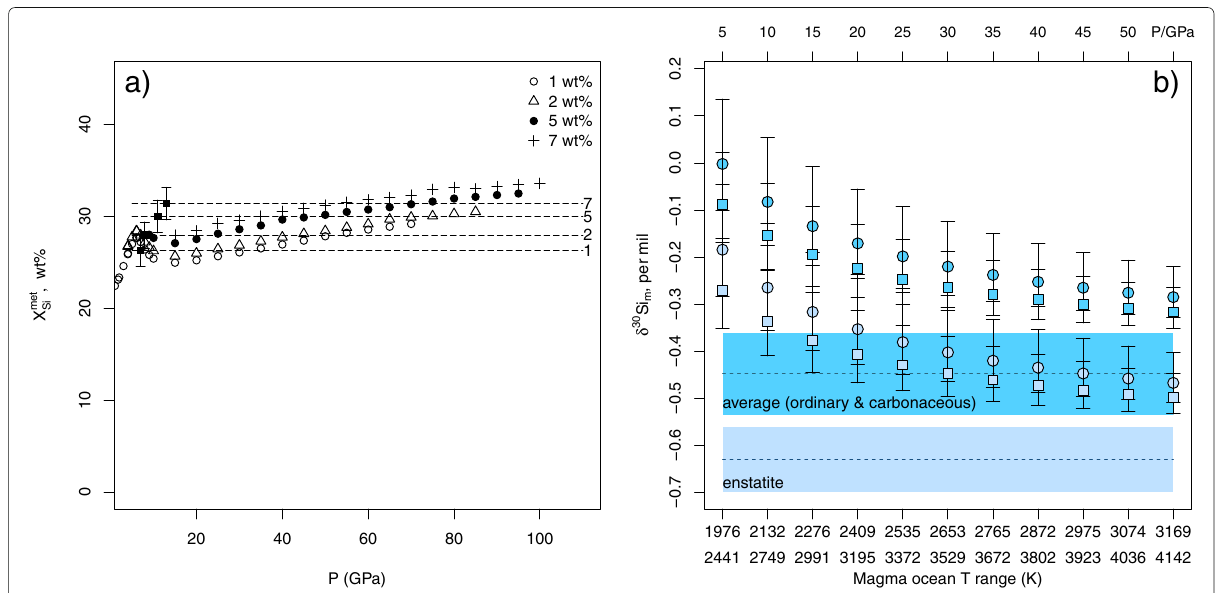
Fig. 5 a Silicon content of Mercury’s core assuming metal-silicate equilibration at pressures prior to mantle stripping. Points show X met formation at specified pressure for different metal S content (1, 2, 5, and 7 wt%). Horizontal dashed lines show the mean for each assumed core sulfur content. b Calculated δ 30 Si m for fractionation at various temperatures corresponding to the depth of a magma ocean and growing core mass on proto-Mercury. Colored bands show mean and ± 2 σ uncertainties for δ 30 Si for major chondritic meteorite classes. Points show predicted fractionation in silicate for ∼ 2 wt% S content if δ 30 Si b corresponds to enstatite or ordinary and carbonaceous classes, and would be the predicted δ 30 Si for meteorites derived from fragments of Mercury’s stripped mantle. All estimates are ∼ 0.1 (cid:3) higher than their chondritic parents’ means. Circles and squares are from experimentally determined fractionation factors of Shahar et al. (2011) and the composite estimate (see the “Methods” section),